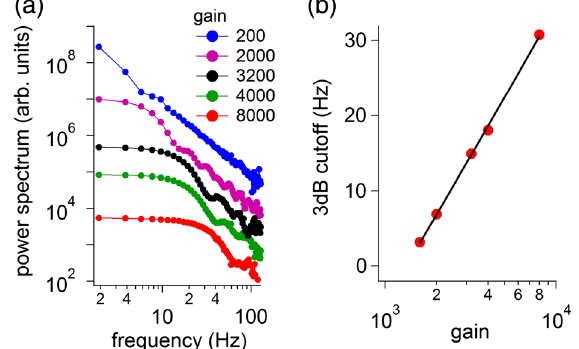
FIG. 4. (a) The power spectrum of the HFM steering angle set value to step deflection is shown in Fig. 3 for varying feedback gain. Curves have been offset for clarity. (b) The 3 dB cutoff increases linearly with feedback electronic